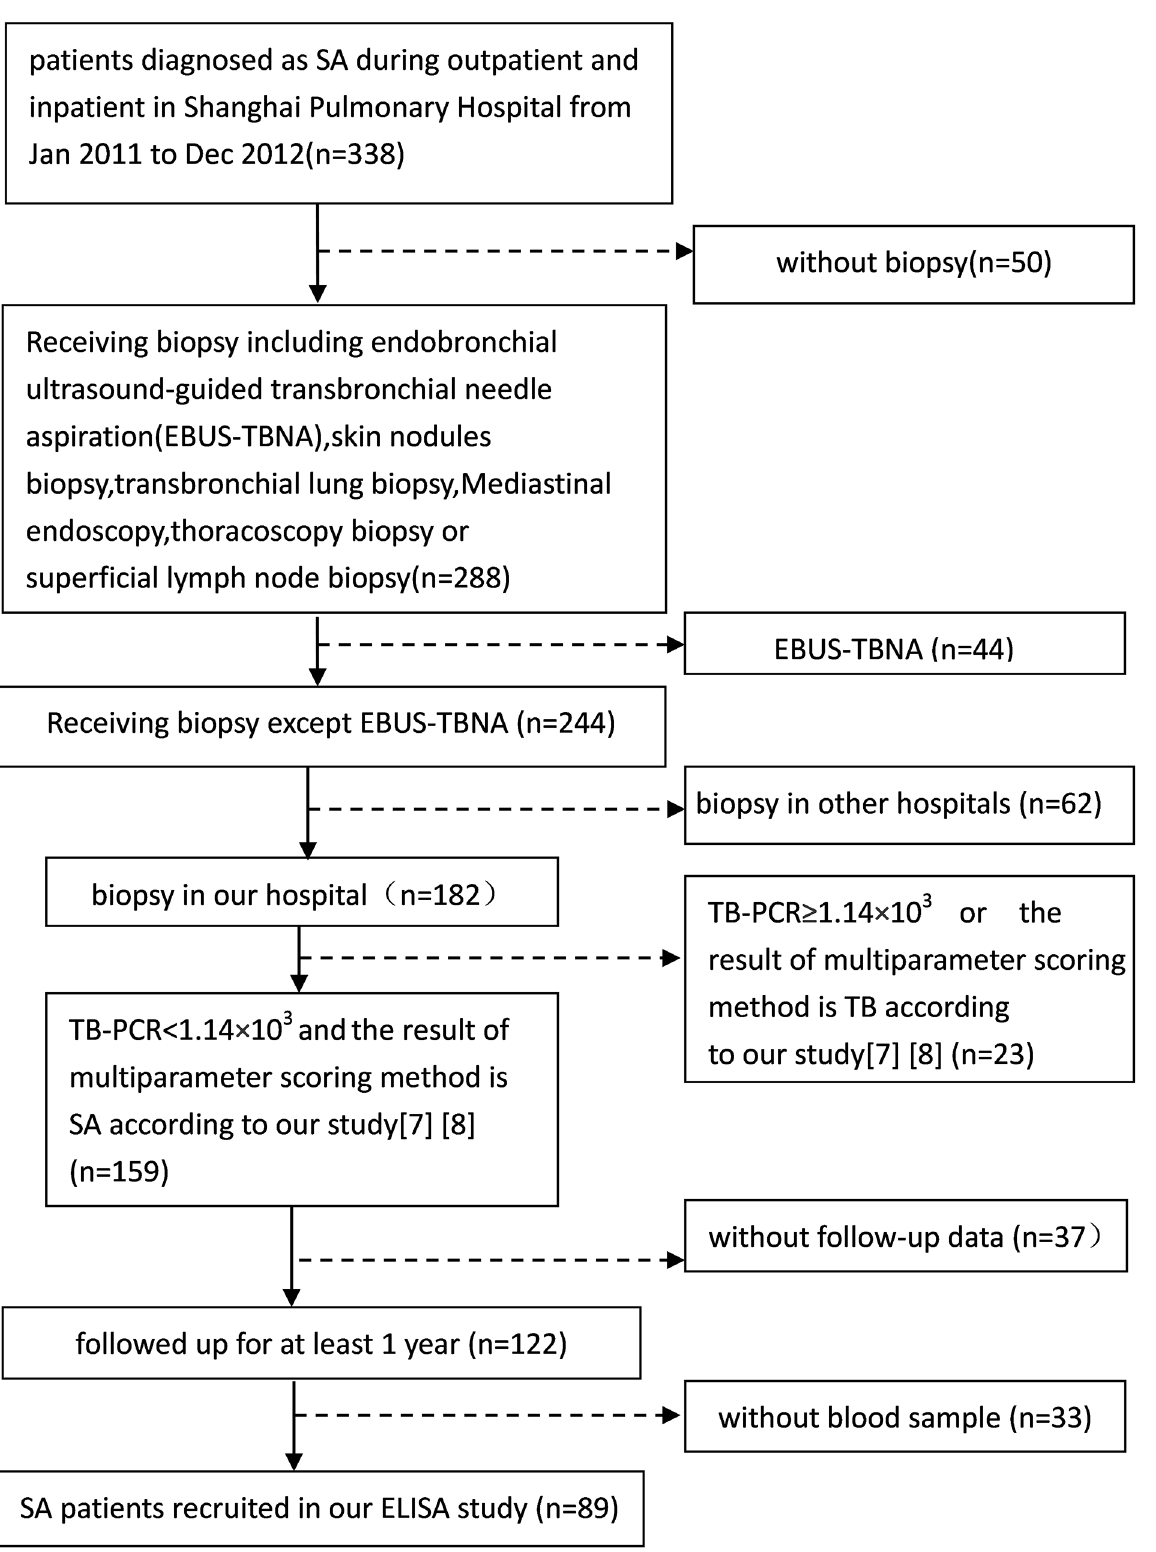
Fig 1. Procedure for recruiting SA patients.